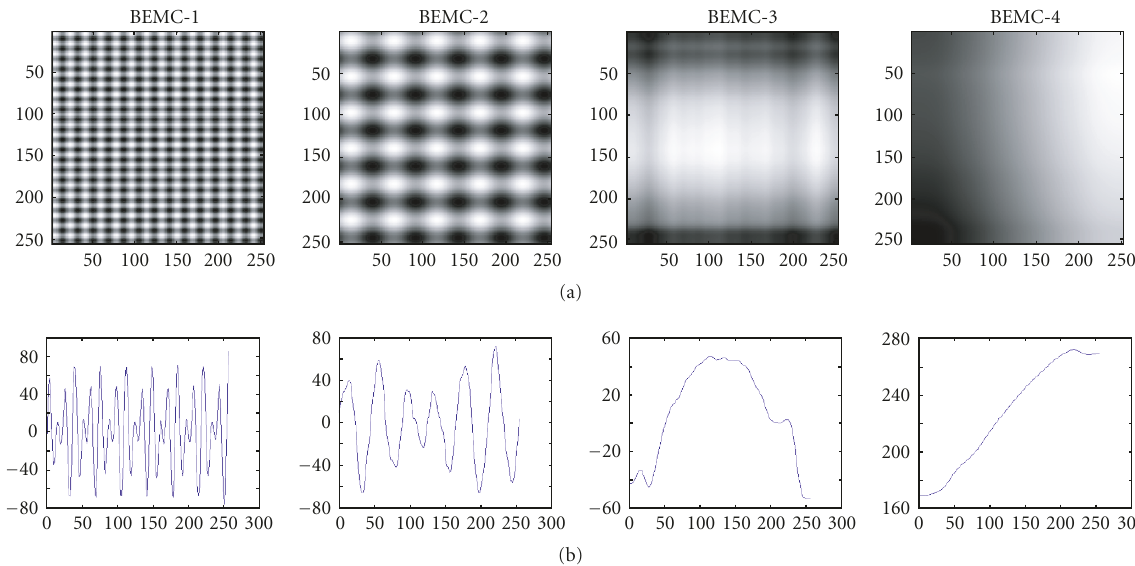
Figure 13: Decomposition of the STI using FABEMD with Type-4 OSFW (MNAI = 5) (a) BEMCs (b) diagonal intensity profiles of BEMCs.